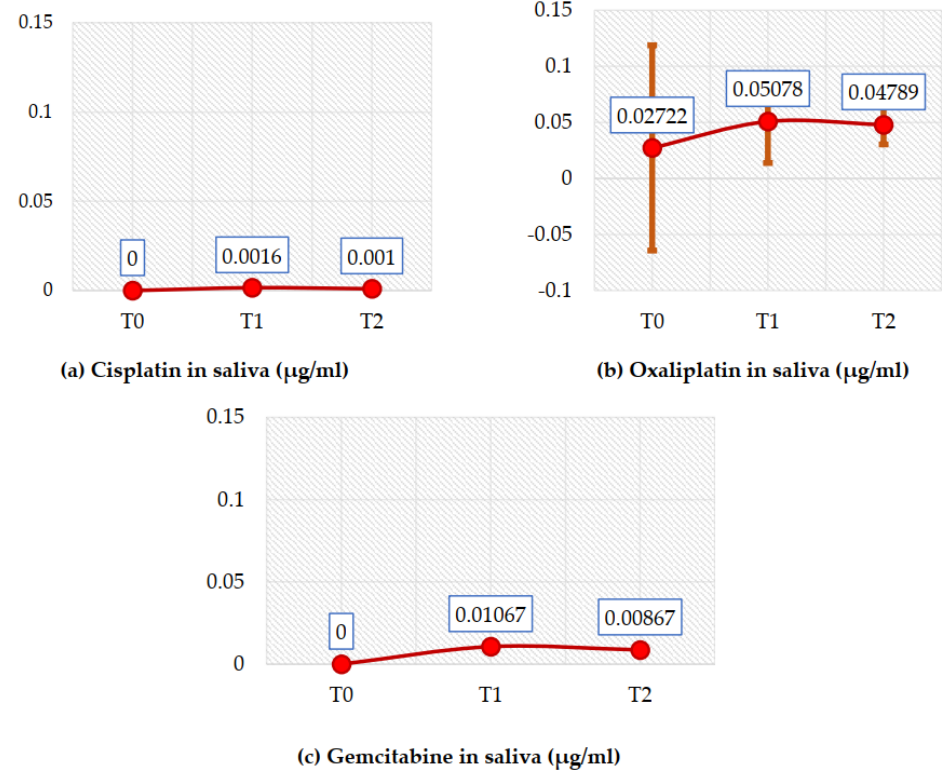
Figure 4. Mean values of chemotherapy drugs detected at T0, T1 and T2 in saliva. ( a ) Mean values of cisplatin concentration (µg/mL); ( b ) mean values of oxaliplatin concentration (µg/ml); ( c ) mean values of gemcitabine concentration (µg/mL). Table 3. Wilcoxon test for chemotherapy concentration comparison in T0, T1, and T2.